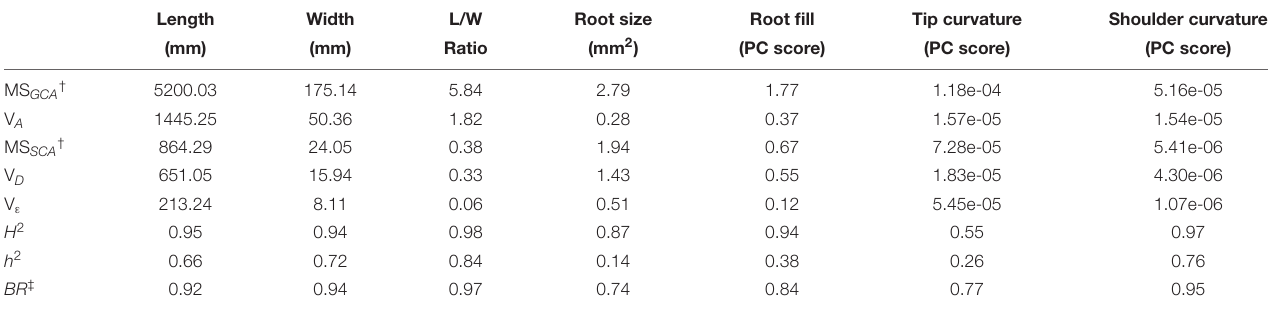
TABLE 1 | Parameters estimated from ANOVA of the half-diallel using Griffing’s Method IV, Model 1. Variance components and heritabilities are reported for the primary size and shape traits which define market class. Length Width L/W Root size Root fill Tip curvature Shoulder curvature (mm) (mm) Ratio (mm 2 ) (PC score) (PC score) (PC score) MS GCA † 5200.03